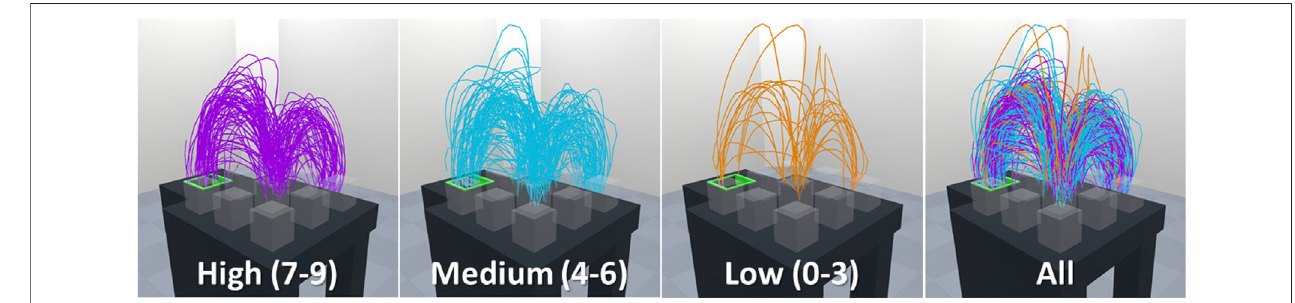
FIGURE 7 | Visualization of the users ’ hand movement while performing the task grouped by PT score.